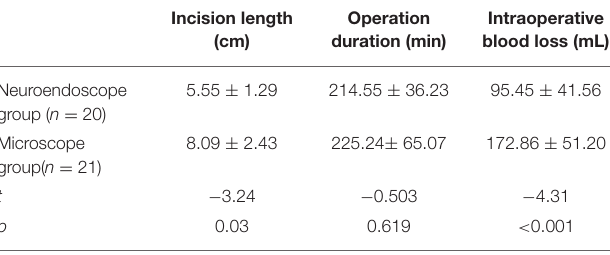
TABLE 3 | Intraoperative indicators in the UHMV and UHNV groups.